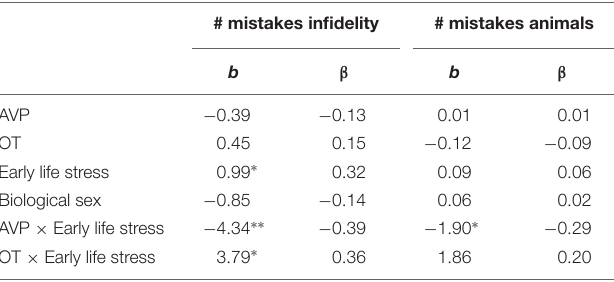
TABLE 3 | Regression coefficient for predicting the accuracy in detecting infidelity and poisnious animals by AVP, OT, and early life stress (Study